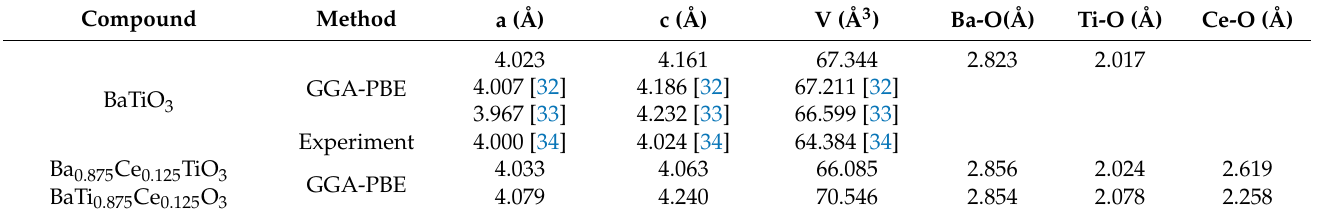
Table 1. Optimized lattice parameters, cell volume, and average bond length for pristine and Ce- doped BaTiO 3